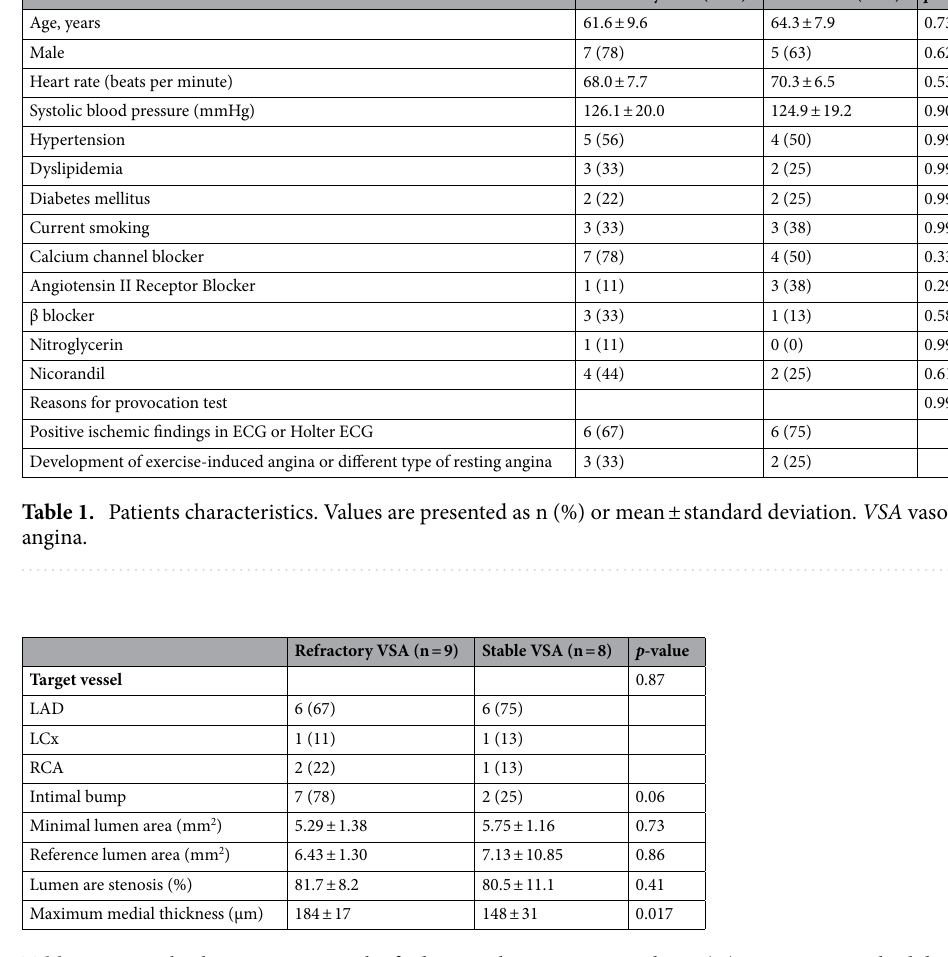
Table 2. Optical coherence tomography findings. Values are presented as n (%) or mean ± standard deviation. VSA vasospastic angina, LAD left anterior descending artery, LCx left circumflex artery, RCA right coronary